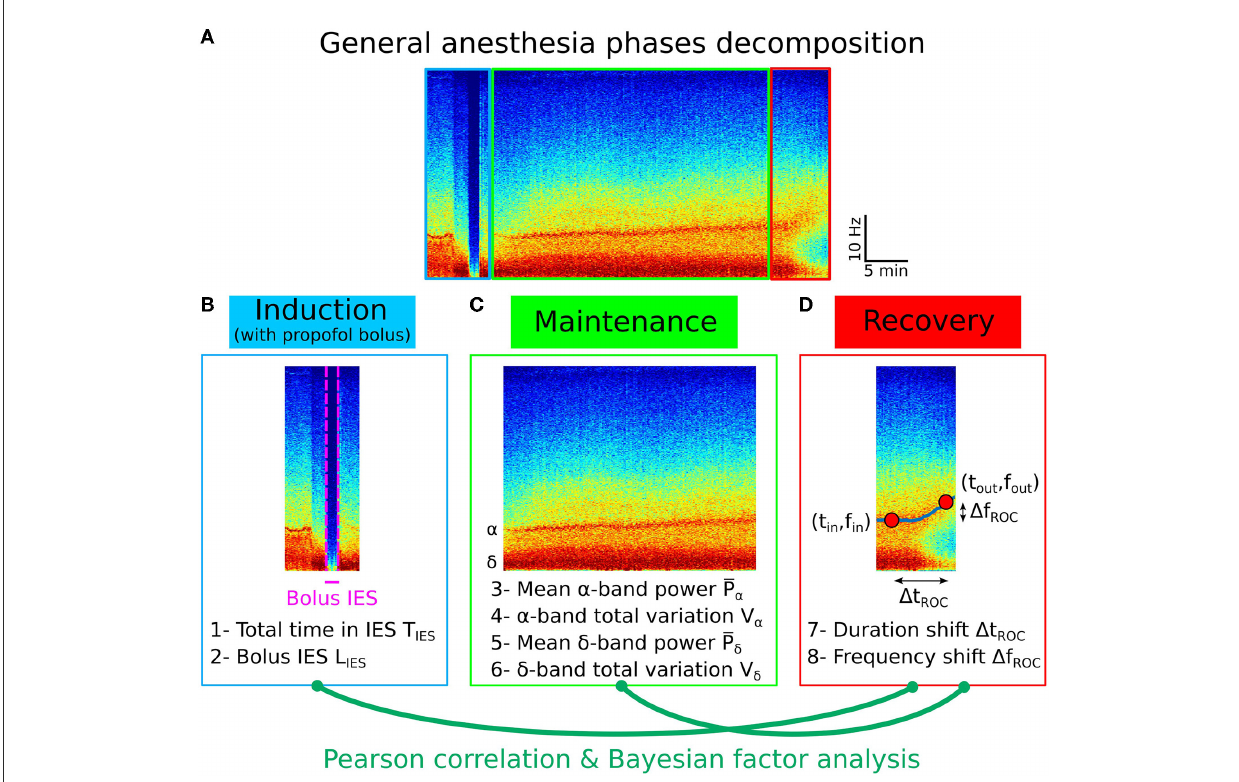
FIGURE4 Pearson correlation analysis of the three phases of general anesthesia. (A) Spectrogram (time-frequency) representation of the EEG signal during the three phases: induction (blue), maintenance (green), recovery (red). (B) Statistical parameters collected during induction: 1- Total time in IES S IES , 2- Longest IES duration L IES . (C) Statistical parameters collected during maintenance: 3- Mean α − band power P α , 4- α − band total variation V α , 5- Mean δ − band power P δ , 6- δ − band total variation V δ . (D) Statistical parameters collected during recovery: 7- Duration shift 1 t ROC , 8- Frequency shift 1 f ROC